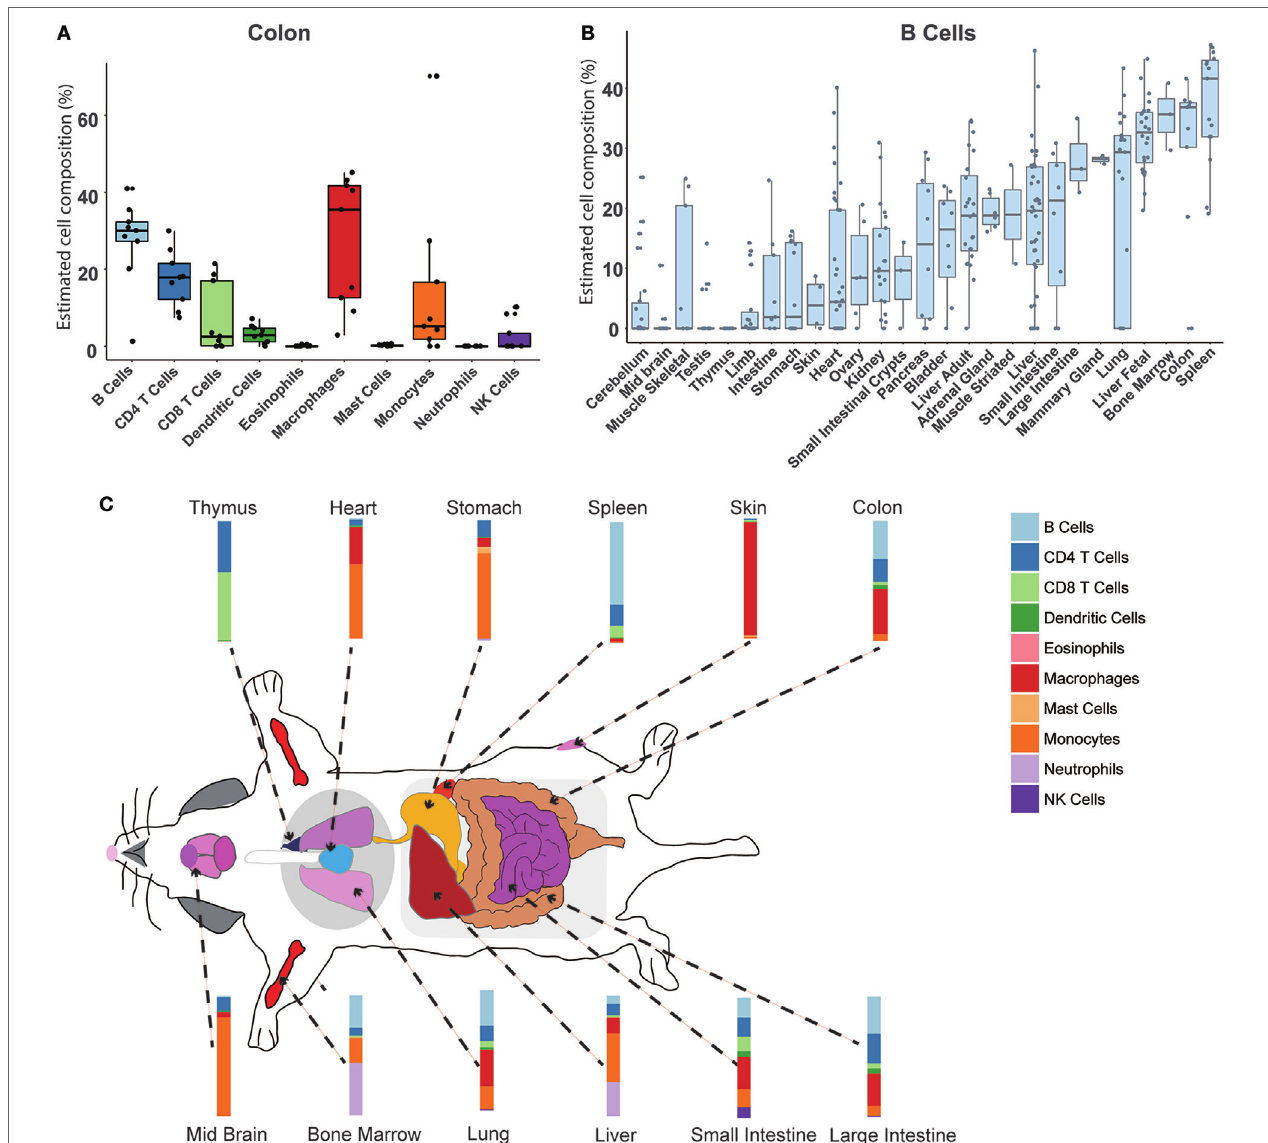
FIGURe 4 | Atlas of immune cell compositions in normal mouse tissues. (A) . Inferred proportions of 10 immune cells in the colon. (B) Distribution of B cell proportion across 27 mouse tissues. (C) Immune cell fingerprint in 12 representative mouse